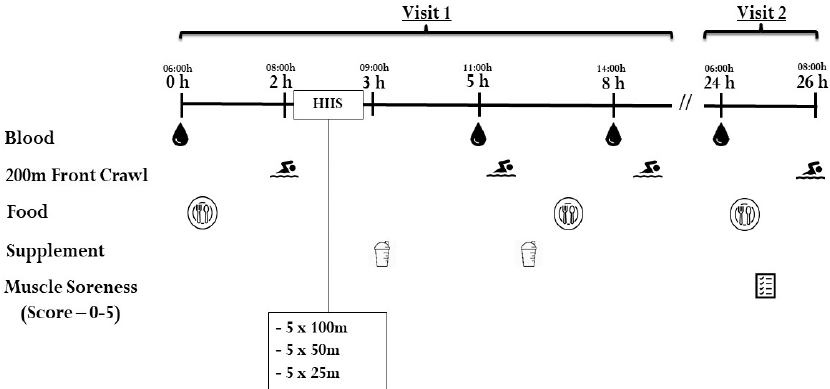
Figure 1. Study design and procedures. HIIS = high intensity interval swimming.